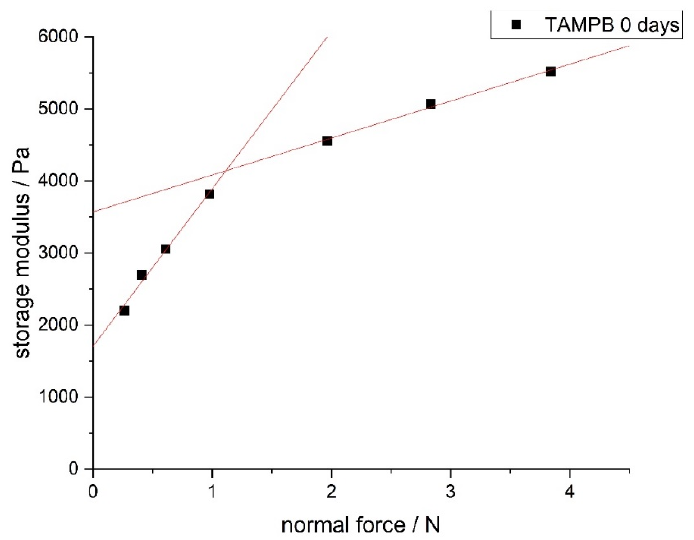
Figure 6. Storage modulus of a poly(DADMAOH) hydrogel with 2 mol% TAMPB and 8 mol% methacrylamid as a function of the applied normal force. The values were recorded at an amplitude of 1% and a frequency of 1 Hz 4 weeks after starting the polymerization.